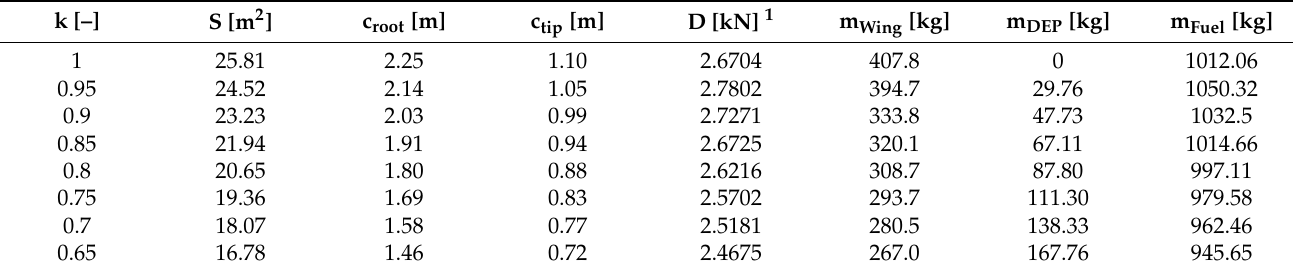
Table 5. Flight performance of DEP aircraft-fuel